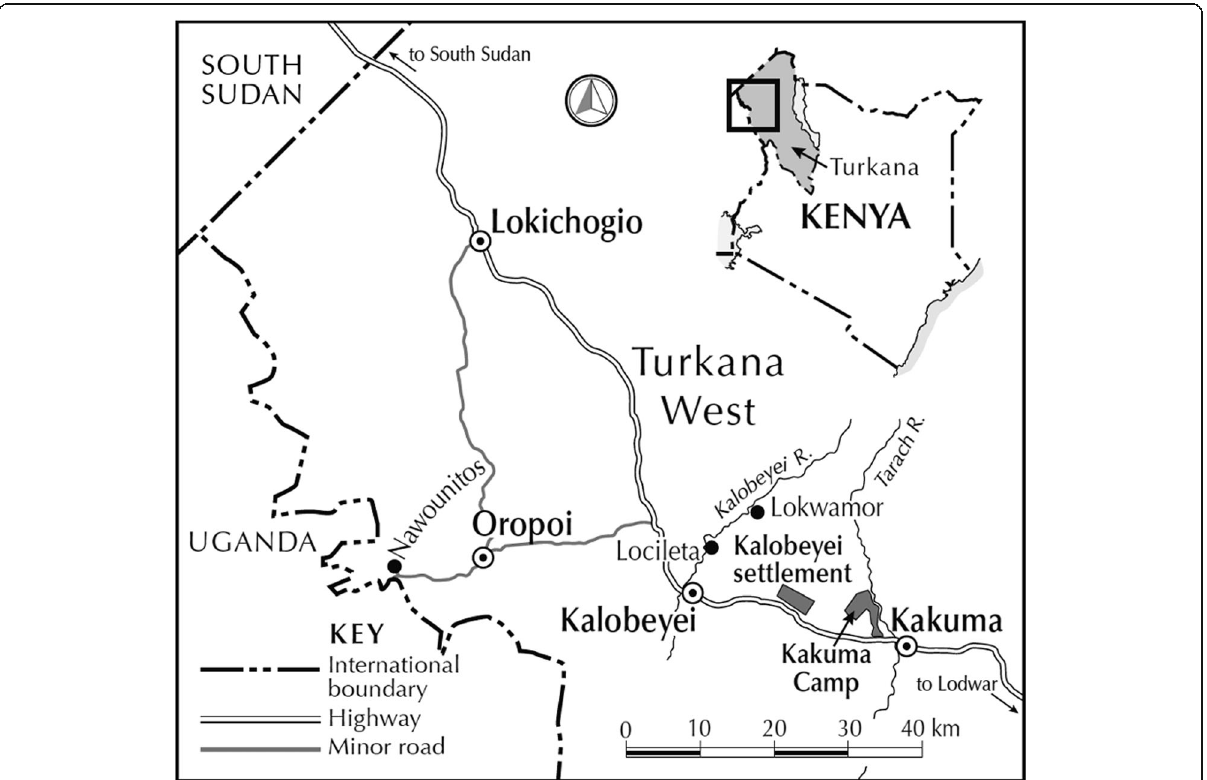
Fig. 1 Map of relevant sites in Turkana West sub-County. Coordinates of major centres and refugee settlements are publicly available, while coordinates of smaller settlements and rural locations were recorded during fieldwork using phone-based GPS. (Produced by John Hall, 2020, at the author ’ s